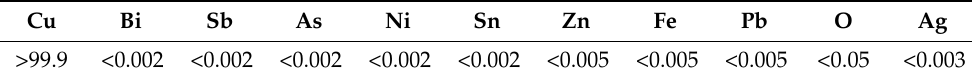
Table 9. Chemical composition of M1 copper foil in %.